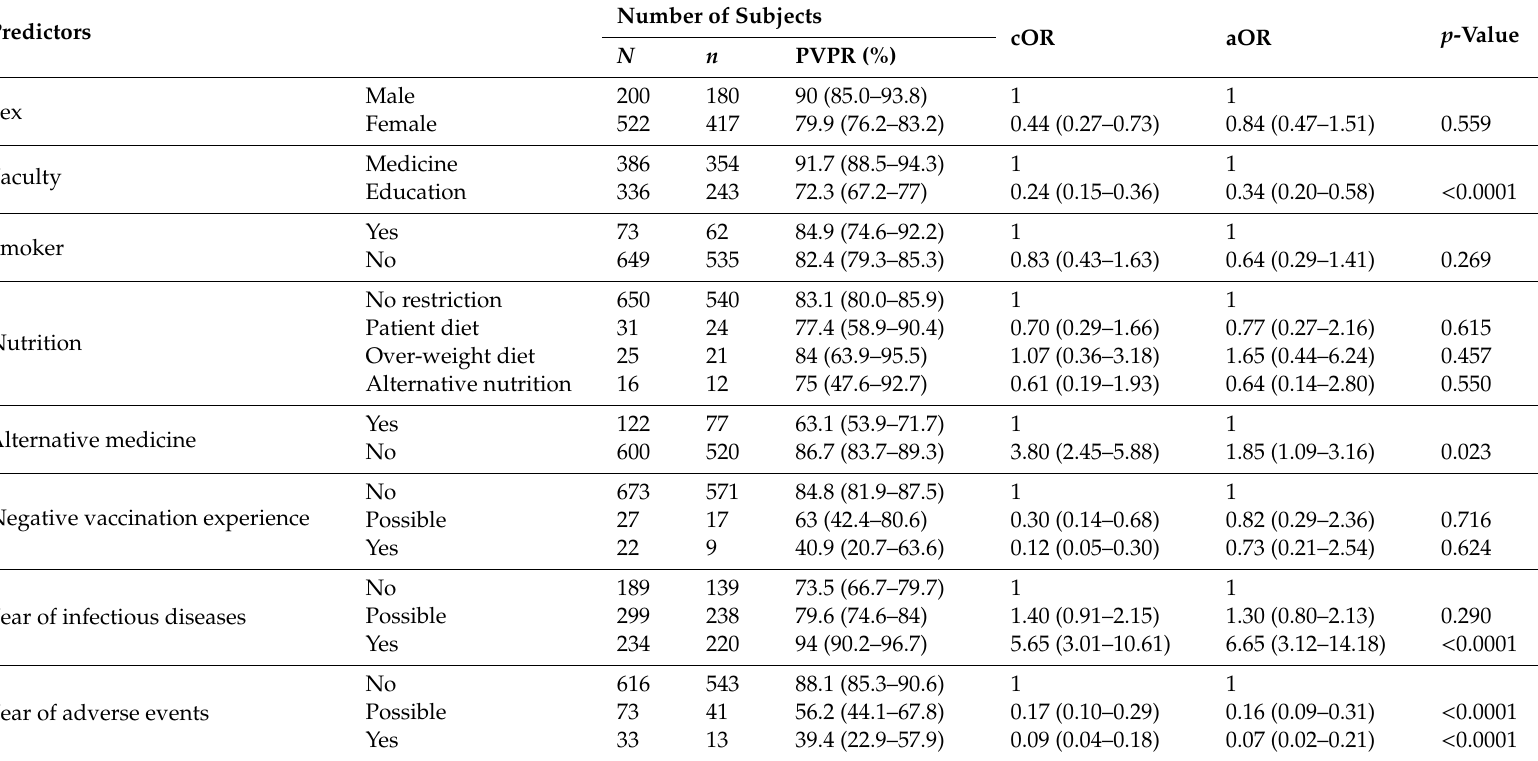
Table 2. Positive vaccination perception rate (PVPR) and odds ratio (gross cOR and mutually adjusted aOR) for the whole sample of respondents.